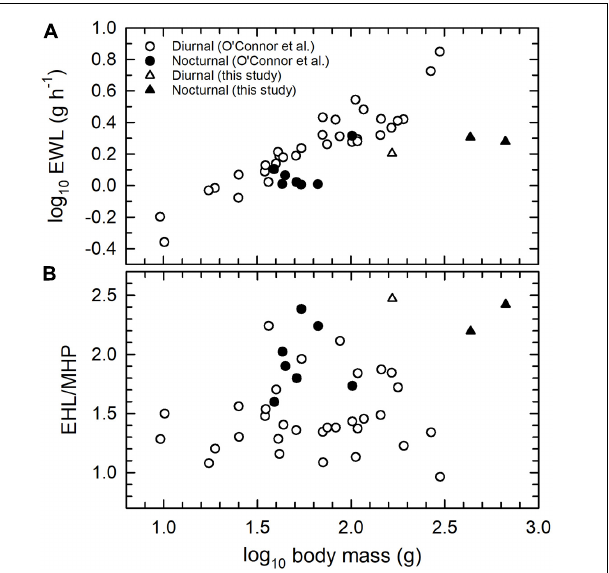
FIGURE 6 | Scaling of log 10 evaporative water loss (EWL; A ) and the ratio of evaporative heat loss (EHL) to metabolic heat production (MHP; B ) at an air temperature ( T air ) of 46 ◦ C in diurnal and nocturnal birds. Most data are from the sources cited by O’Connor et al. (2018), with additional data from the present study (triangles) for Namaqua sandgrouse ( Pterocles Namaqua , diurnal), spotted thick-knee ( Burhinus capensis , nocturnal) and spotted eagle-owl ( Bubo africanus ,